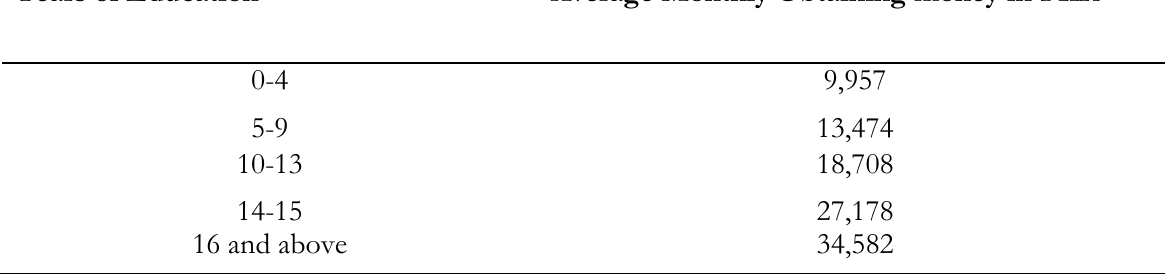
Table 1. Education and Average Earnings in